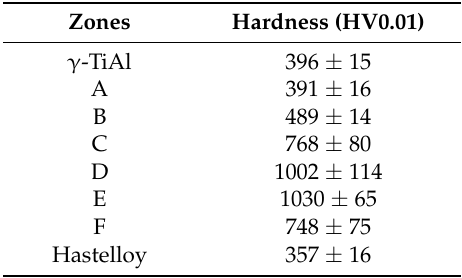
Table 2. Average hardness values (HV0.01) of the different layers detected at the interface produced at 980 ◦